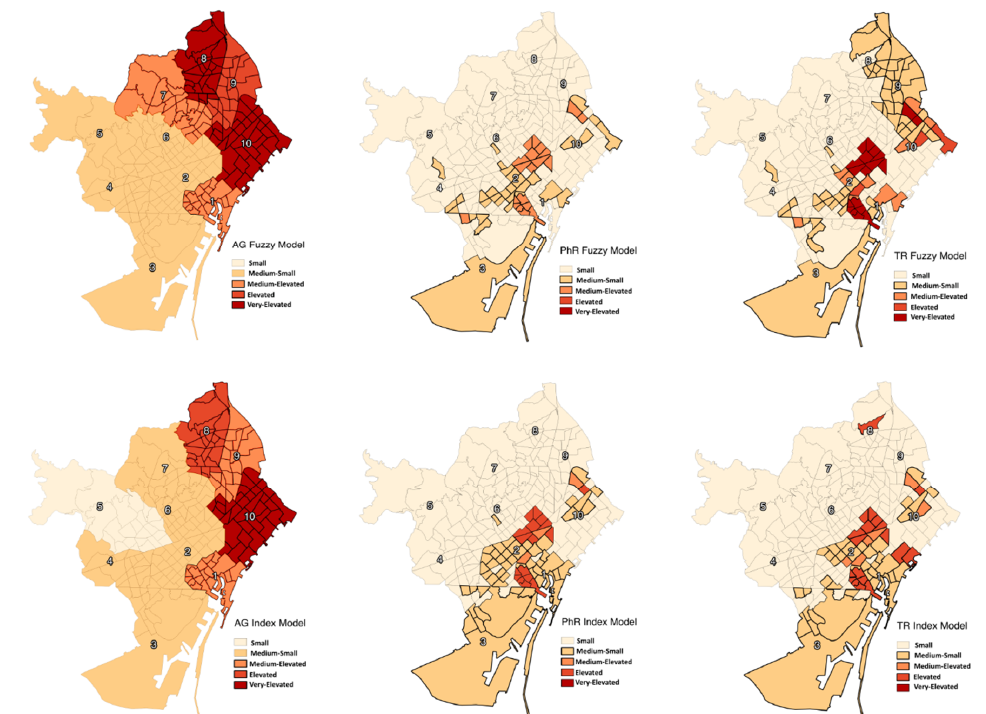
Figure 4. Risk components obtained for Barcelona city by the fuzzy model (upper row) and the index model (lower part). From left to right: social aggravation, physical risk, and total seismic risk. Significant values of each component have been highlighted to show a measure of how the assumption of compensability can lead towards different risk spatial patterns. Regardless of the resemblances between the spatial configurations estimated by the two models for social aggravation and physical risk levels, it is clear how a linear aggregation produces a different total risk pattern.